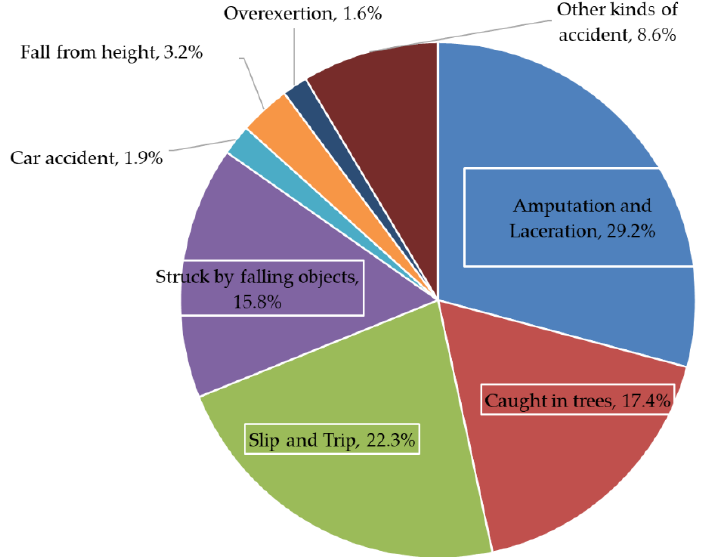
Figure 6. Distribution of occupational accident rates by injury patterns.